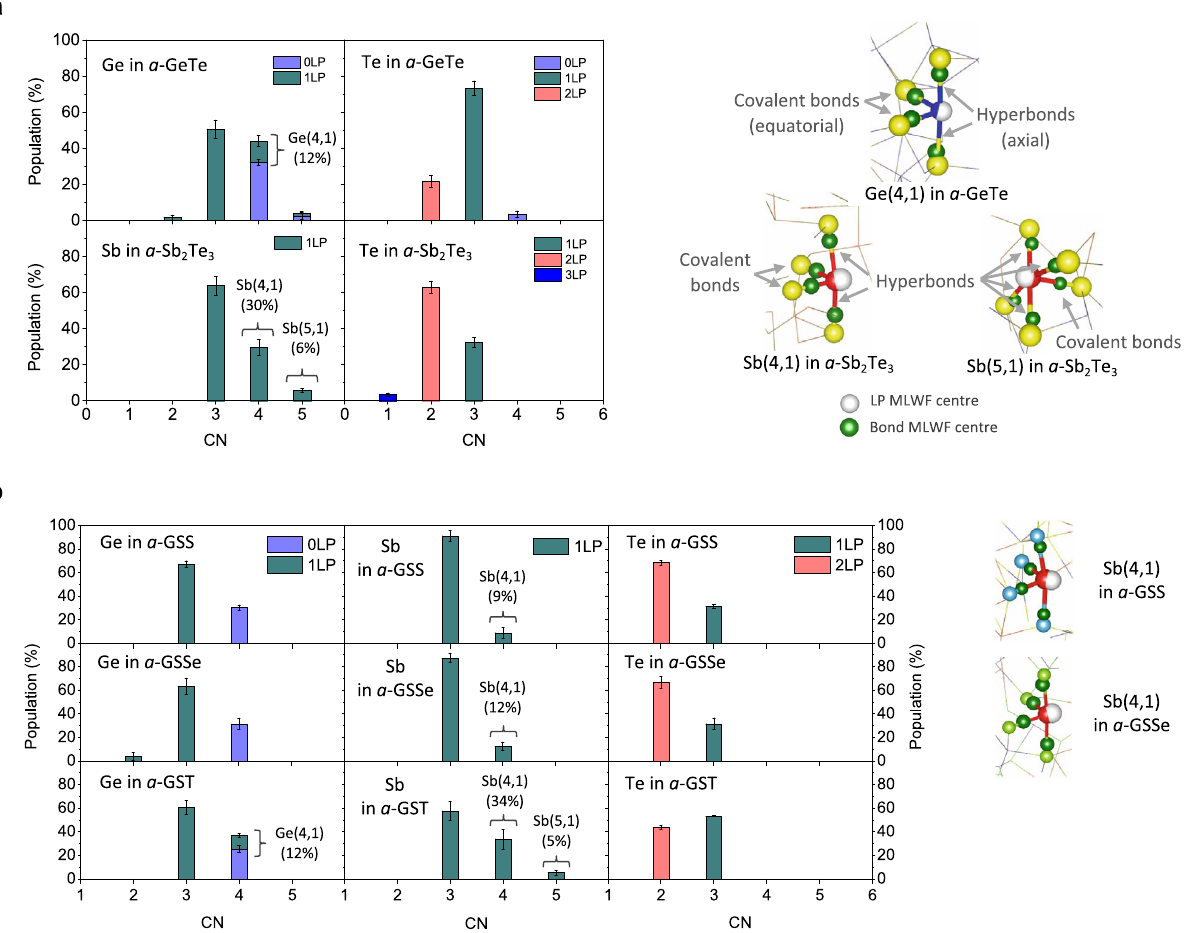
Fig. 2 Structural units in binary and ternary amorphous chalcogenides. a Populations of structural units in the binary tellurides, a -GeTe (upper panels) and a -Sb 2 Te 3 (lower panels). Representative bonding geometries of (4,1)- and (5,1)-type hypervalent units are shown. The positions of MLWF centres for hyperbond pairs, covalent bonds and lone pairs (LPs) are speci fi ed for each type of hypervalent unit. b Populations of structural units in ternary chalcogenide models of a -GSS (top panels), a -GSSe (middle panels) and a -GST (bottom panels). For a -GST, data are taken from Lee and Elliott 4 , with error bars being added. For each model, three independently-generated amorphous model structures were analysed, to obtain better statistics. The standard deviation for those model structures is represented by an error